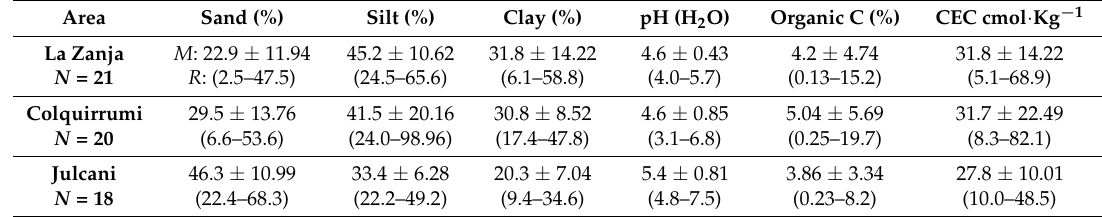
Table 1. Statistical data of the main properties of the soils studied in La Zanja, Colquirrumi, and Julcani.